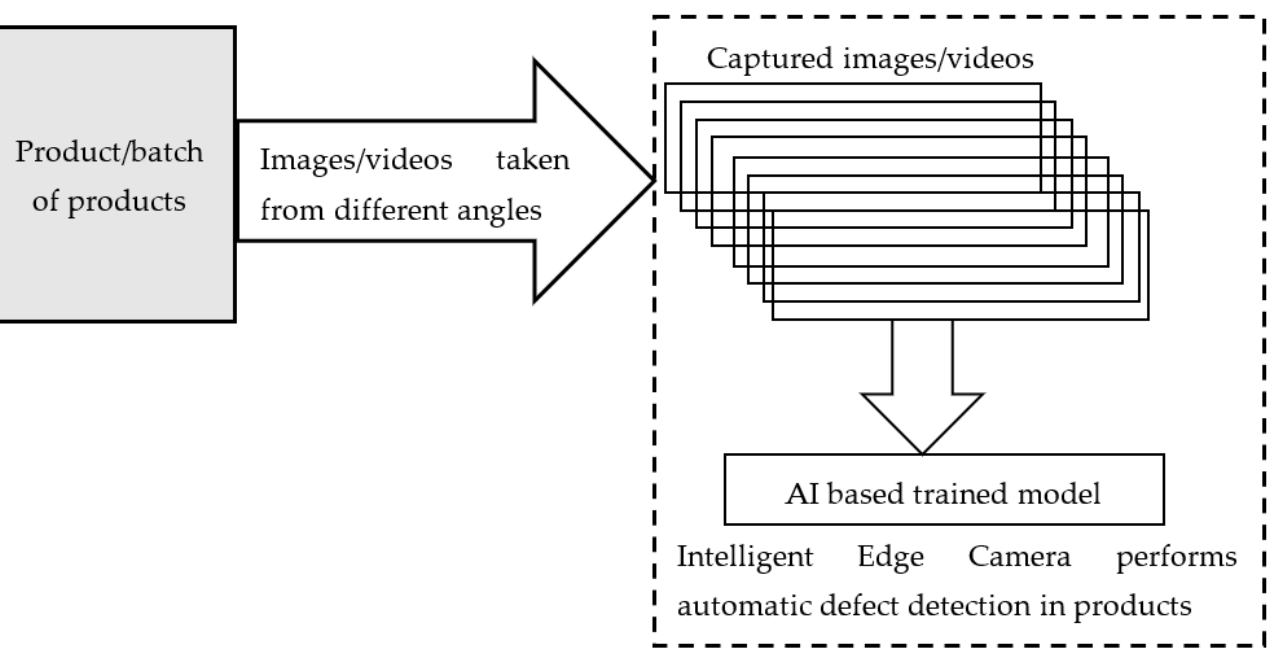
Figure 1. Block diagram of edge AI-based defect detection.